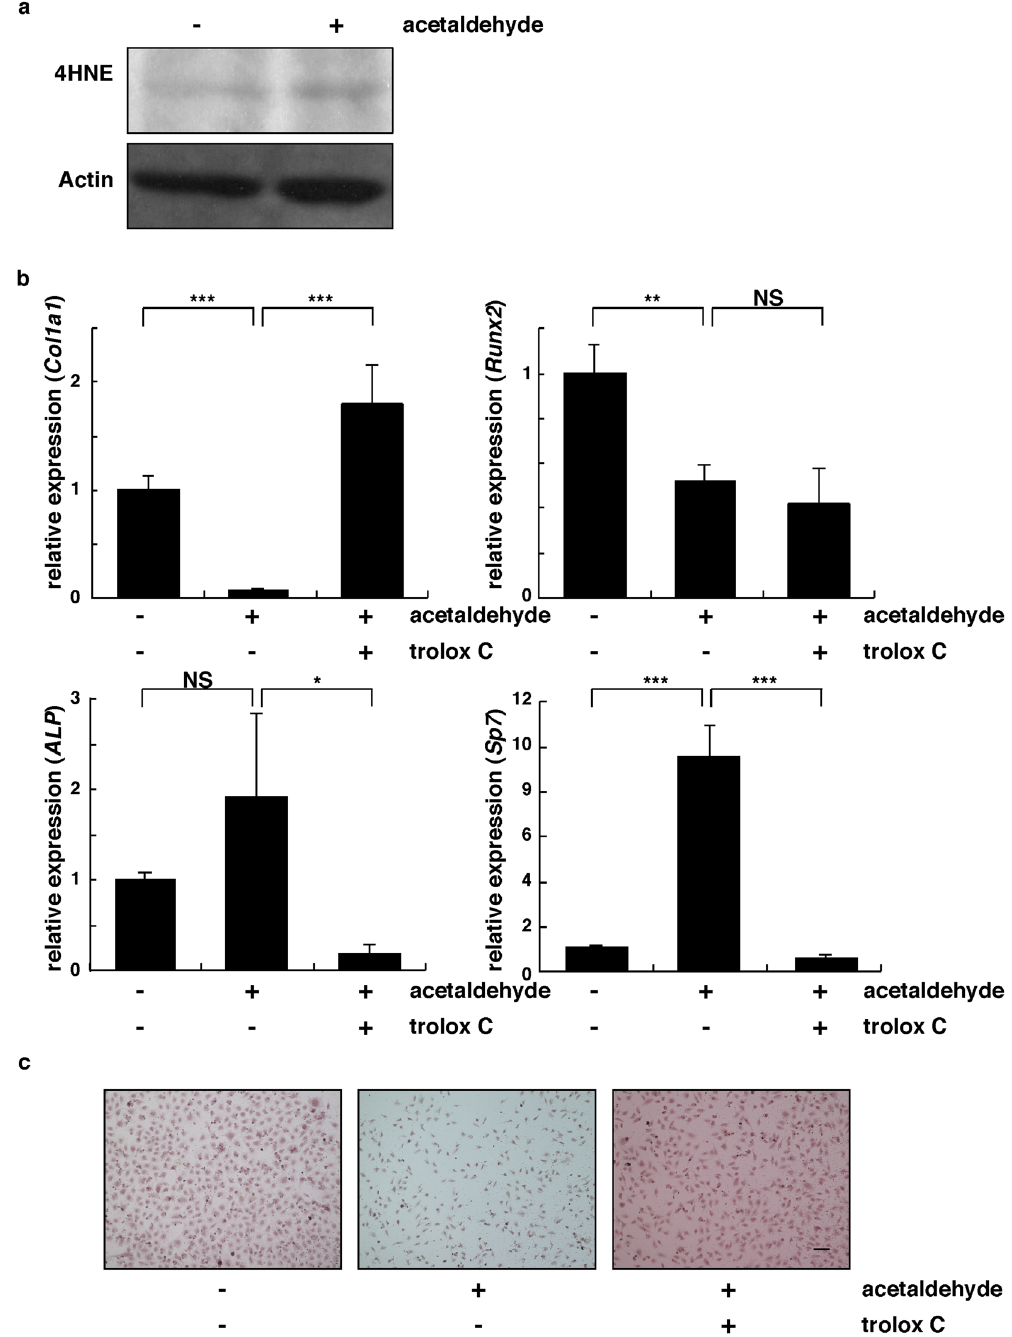
Figure 5. Osteoblast differentiation is inhibited by acetaldehyde and rescued by anti-oxidant treatment. ( a ) Osteoblastic MC3T3E1 cells were cultured in osteogenic medium with or without 0.04% acetaldehyde for 48 hours. Oxidative stress, as indicated by 4-hydroxynonenal (4HNE) levels, was then analyzed by western blot. Actin served as internal control. ( b , c ) MC3T3E1 cells were cultured in α MEM or osteogenic medium with or without 0.04% acetaldehyde and in the presence or absence of the anti-oxidant Trolox C (40 µ M) for 48 hours ( b ) or seven days ( c ). Osteoblast differentiation was then analyzed by realtime PCR based on Col1a1 , Runx2 , ALP and Sp7 expression ( b ) or alizarin red staining ( c ). Data represent mean Col1a11 , Runx2 , ALP or Sp7 expression normalized to that of β -actin ± SD ( n = 3). *** P < 0.001. Representative data of two independent experiments is